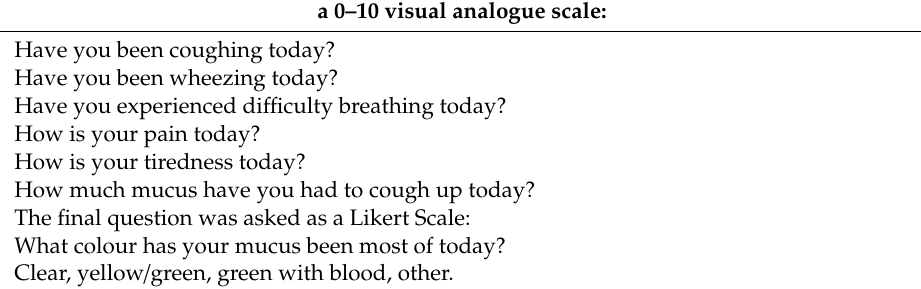
Table 1. Questions presented to